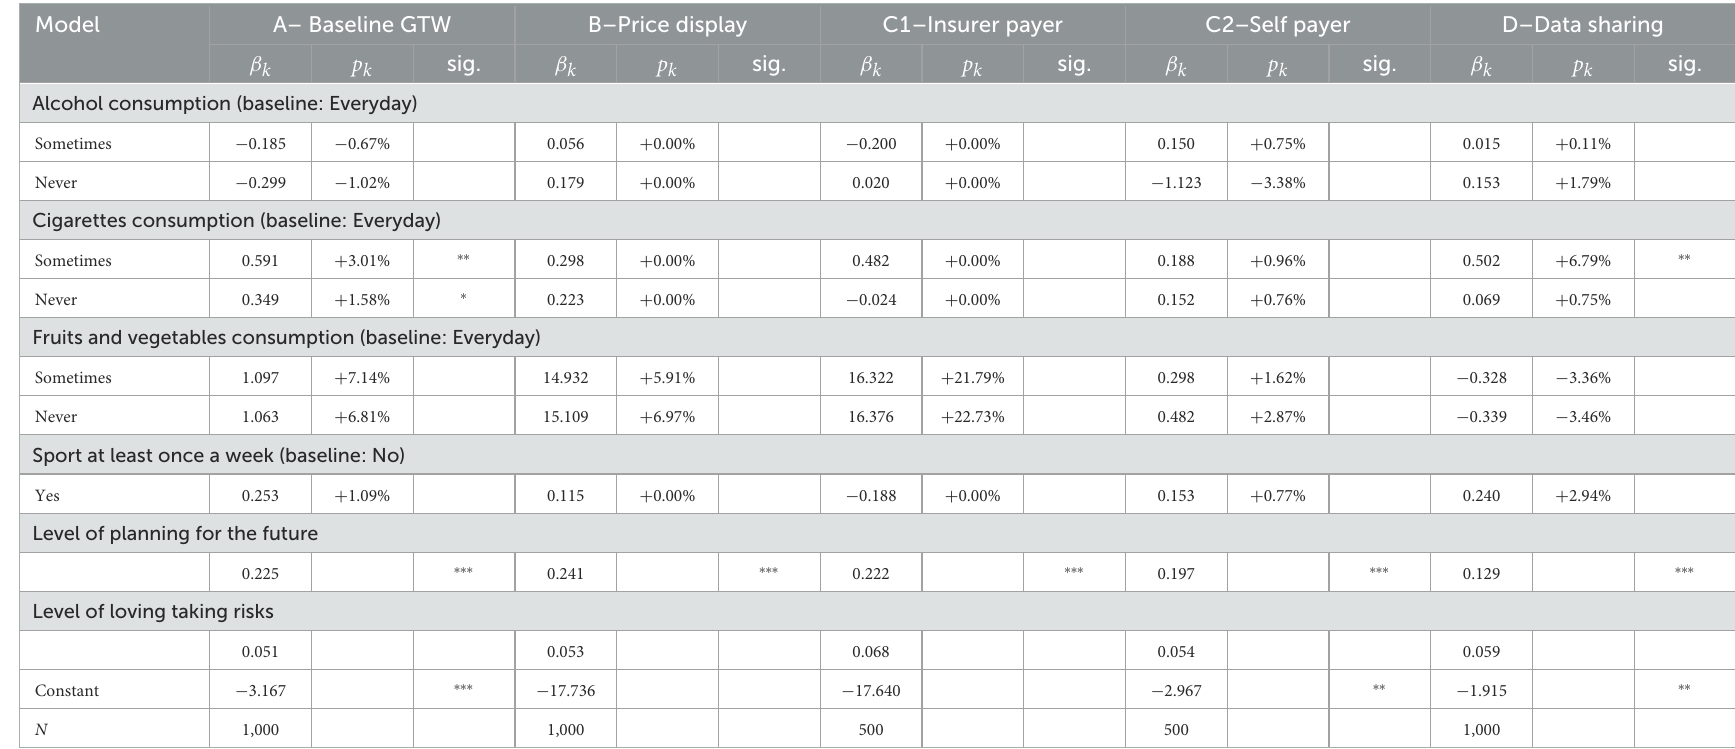
TABLE 6 Regression results for lifestyle